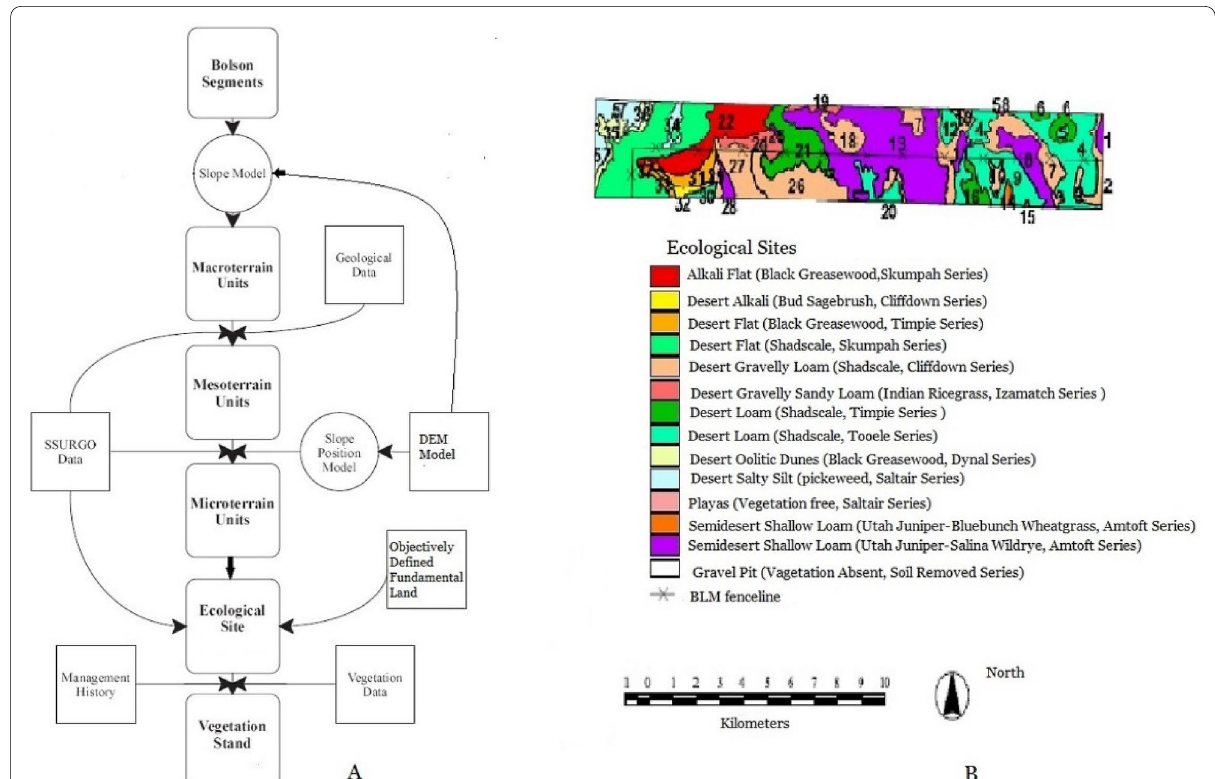
Fig. 4 A Flow diagram of Ecosystem Classification of Land from Bolson Segments to Vegetation Stands. B Map of the ecological sites in project sampling strip